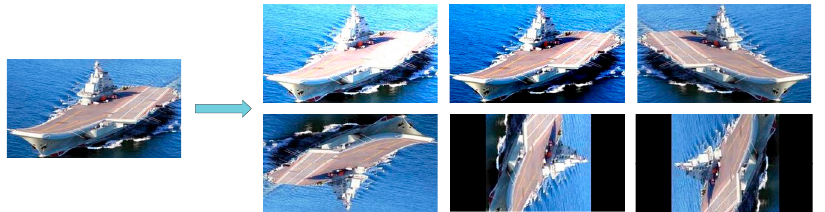
Figure 8. Examples of data enhancement.